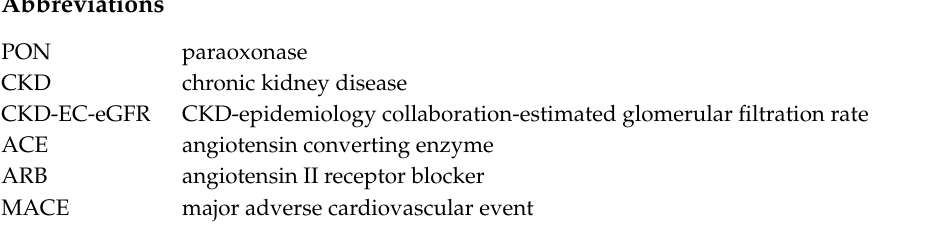
Table S1: Clinical characteristics among participants in the CRISIS clinical trial stratified by CKD etiology, Table S2: Clinical characteristics among non-CKD healthy controls, Table S3: Unadjusted and adjusted 8-year hazard ratio for death at 8 years stratified by quartile values for circulating PON activity, protein adjusted activity levels, and PON-1 protein. Figure S1A: Comparison of circulating PON-1 protein levels across CKD stages, Figure S1B: Comparison of circulating PON lactonase activity across CKD stages, Figure S1C: Comparison of circulating PON protein adjusted lactonase activity across CKD stages. Figure S2A: Comparison of circulating PON-1 protein levels in CKD etiologies, Figure S2B: Comparison of circulating PON lactonase activity in CKD etiologies, Figure S2C: Comparison of circulating protein adjusted activity in CKD etiologies. Figure S3A: Correlation graph showing relationship between PON lactonase activity and PON-1 protein in non-CKD controls, Figure S3B: Correlation graph showing relationship between PON lactonase activity and PON-1 protein in patients with chronic kidney disease. Figure S4. Western blot analysis of PON1 expression in non-CKD control subjects and patients with